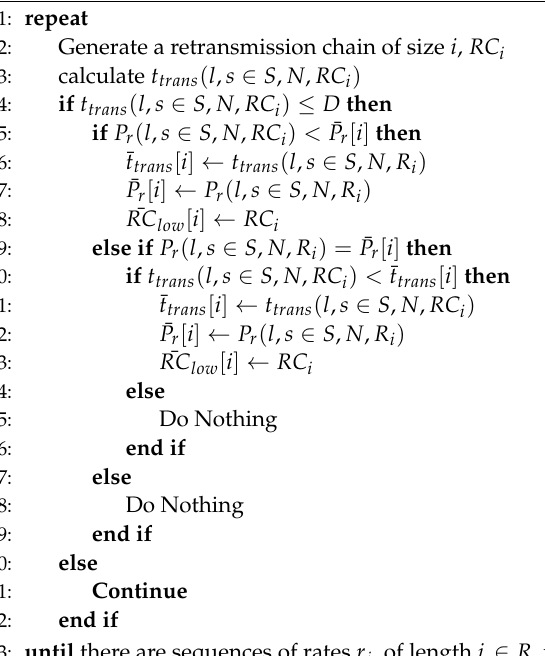
Algorithm 4 Selection of the retransmission chain ensuring the lowest transmission error probability for each value of